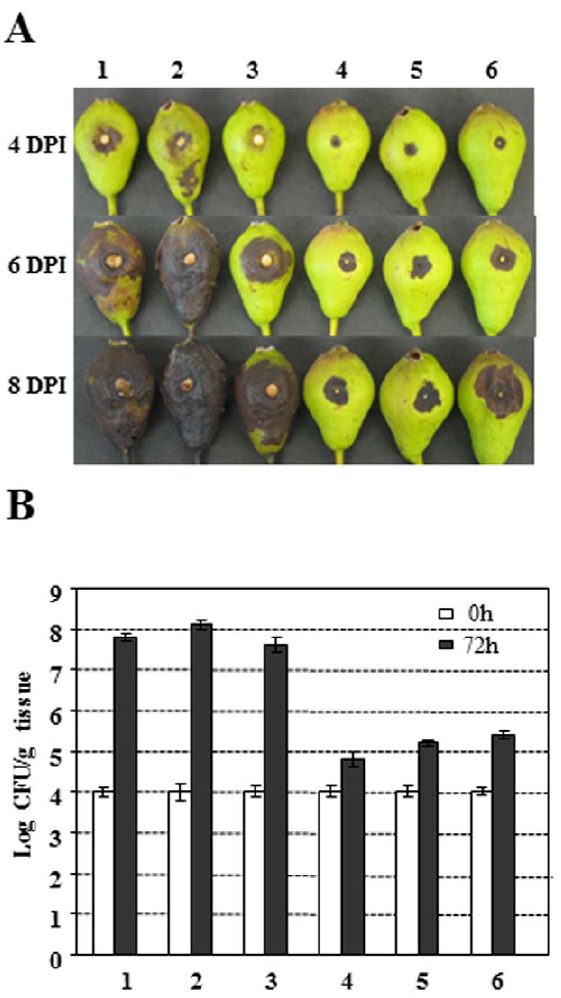
N : caused by Erwinia amylovora wild type (WT), amyR mutant, comple- mentation strain and WT containing pAmyR2 plasmid on immature pear fruits. B . Bacterial growth on immature pear fruits. 1: Ea1189, 2: D amyR , 3: D amyR (pAmyR3), 4: D amyR (pAmyR2), 5: Ea1189 (pAmyR2), 6: Ea1189 (pAmyR3). Growth of bacterial strains was monitored at 0 and 72 h after inoculation. Data points represent means of three replicates 6 standard errors. Similar results were obtained in repeated independent experiments.